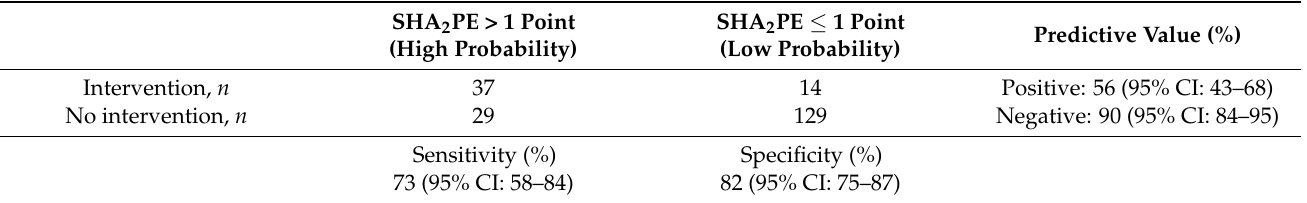
Table 6. SHA 2 PE score